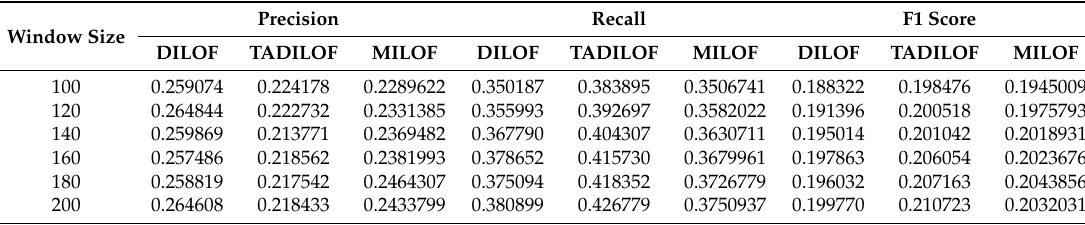
Table 2. Precision, recall, and F1 score on Annthyroid dataset.